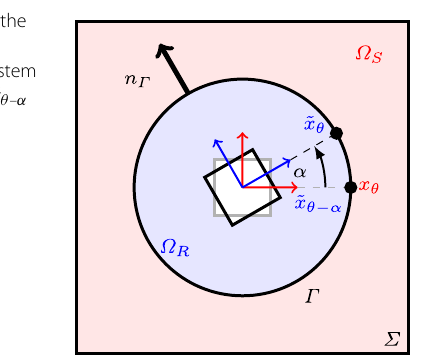
Figure 1 Sketch of the geometry. x θ denotes a point in the fixed coordinate system (red) of the stator domain (cid:2) S , whereas ˜ x θ denotes a point in the rotated coordinate system (blue) of the rotor domain (cid:2) R . They are related by x θ = ˜ x θ – α where α is the angle of